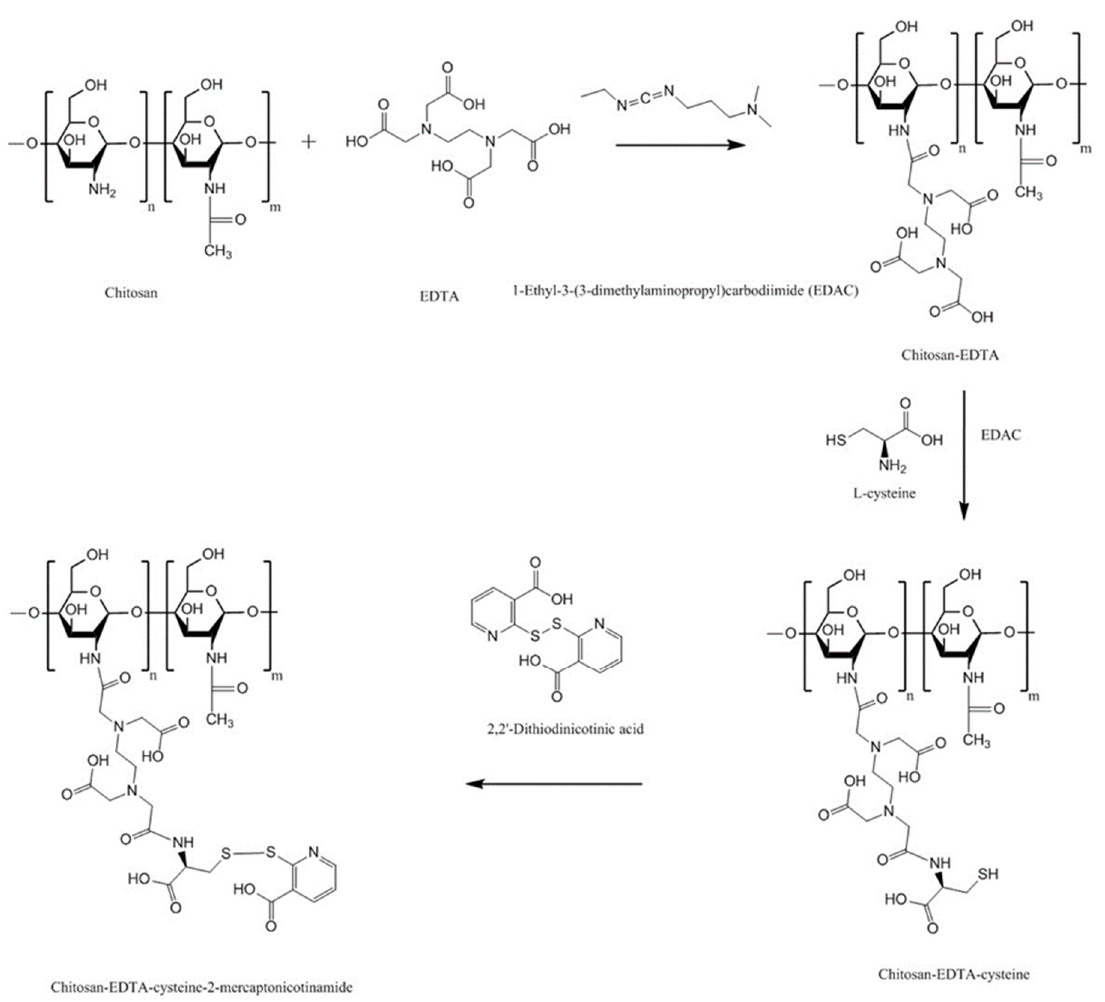
Figure 17. Synthetic pathway to chitosan-EDTA-cysteine-2-mercaptonicotinamide [138].